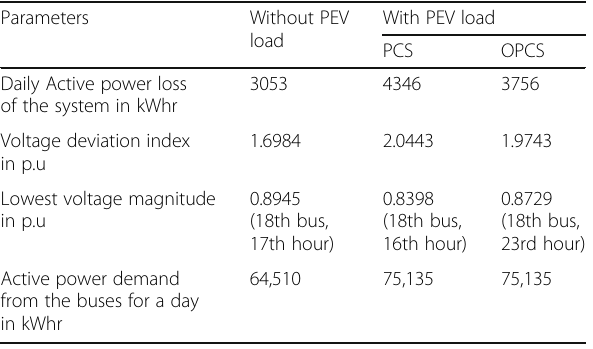
Table 2 Comparison between without and with PEVs load on test system